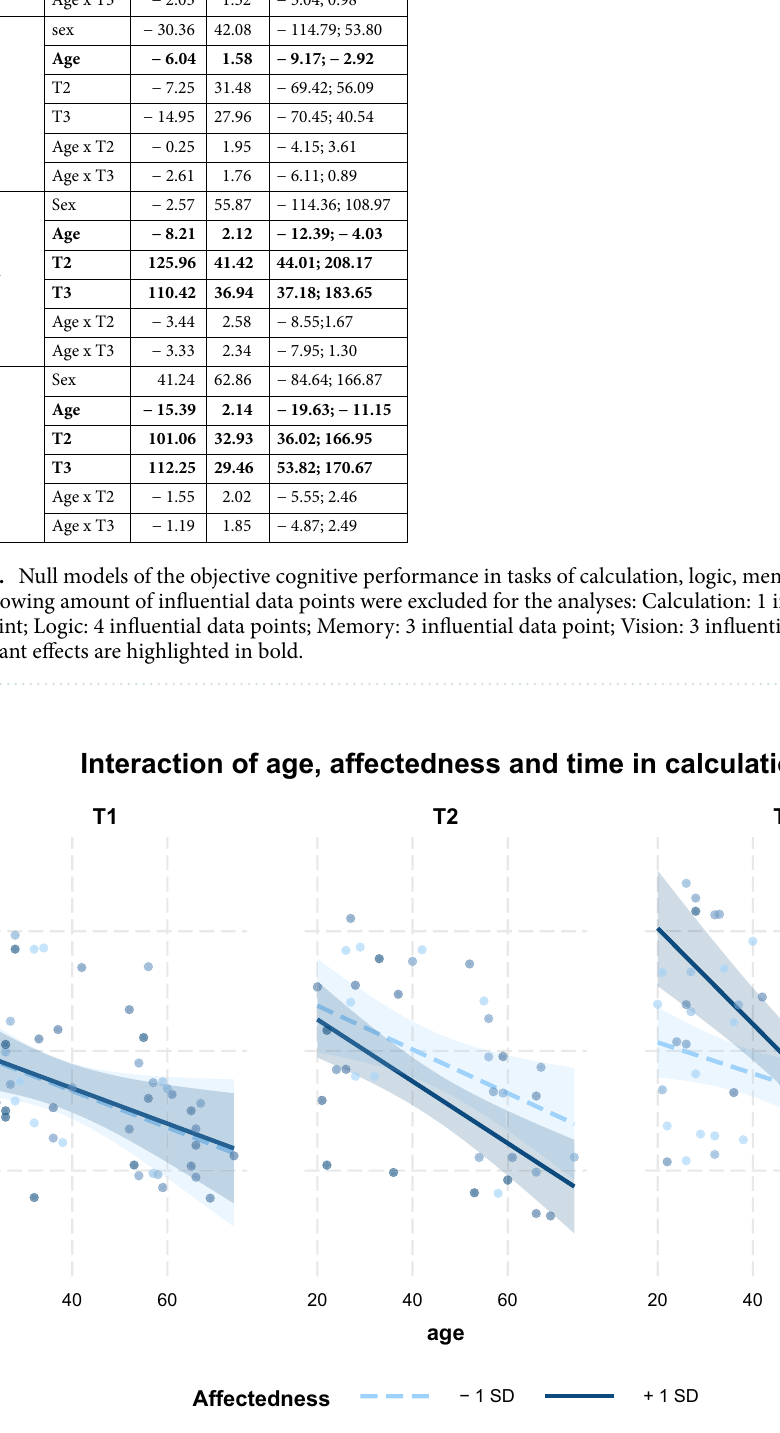
Figure 5. Interaction trend of age, time and affectedness on the calculation task performance. Shaded areas represent 90%-confidence